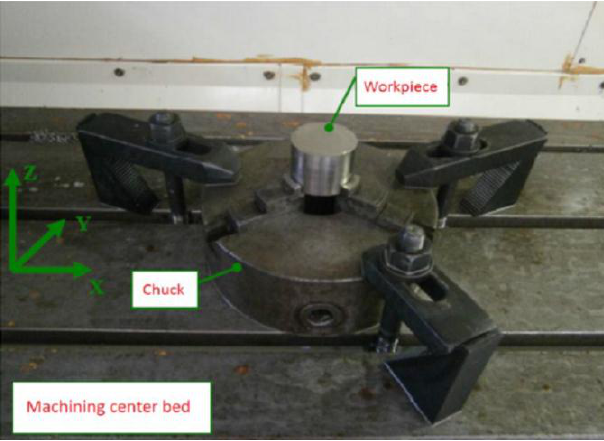
Figure 5. Clamping of workpiece on the machining center bed.